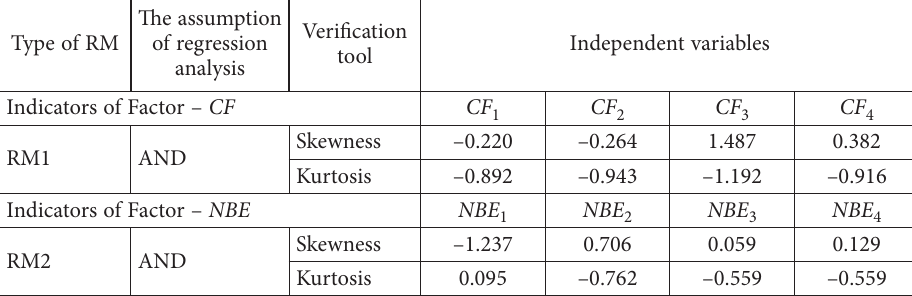
Table 1. Verification of the assumptions of RM1 and RM2 (source: own data collection) The assumption Type of RM of